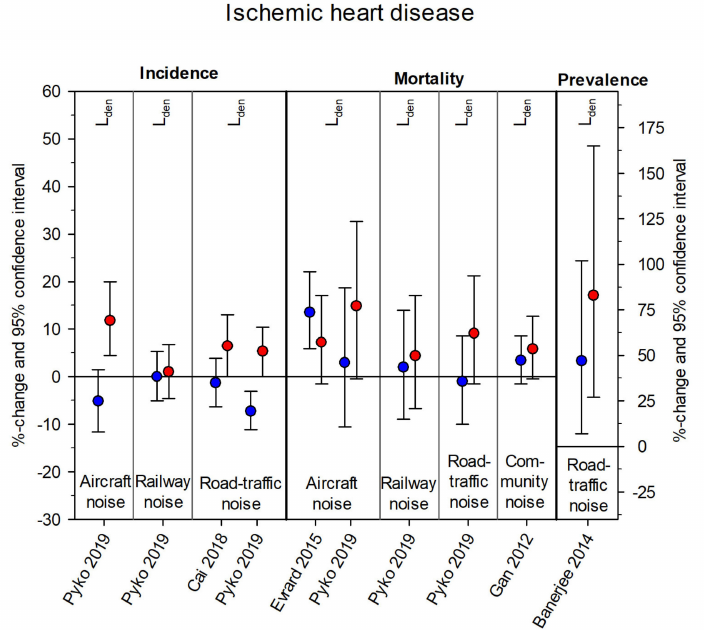
Figure 5. Sex/gender-specific effect estimates from studies with the cardiovascular outcome ischemic heart disease. Effect estimates are displayed as percent changes (blue = males, red = females) and 95% confidence intervals per 5 dB(A) increase in noise exposure (aircraft noise, railway noise, road traffic noise, community noise) and grouped according to frequency measure (incidence, mortality, prevalence) and noise indicator (L den ). The scale on the right side of the figure only applies to Banerjee 2014.